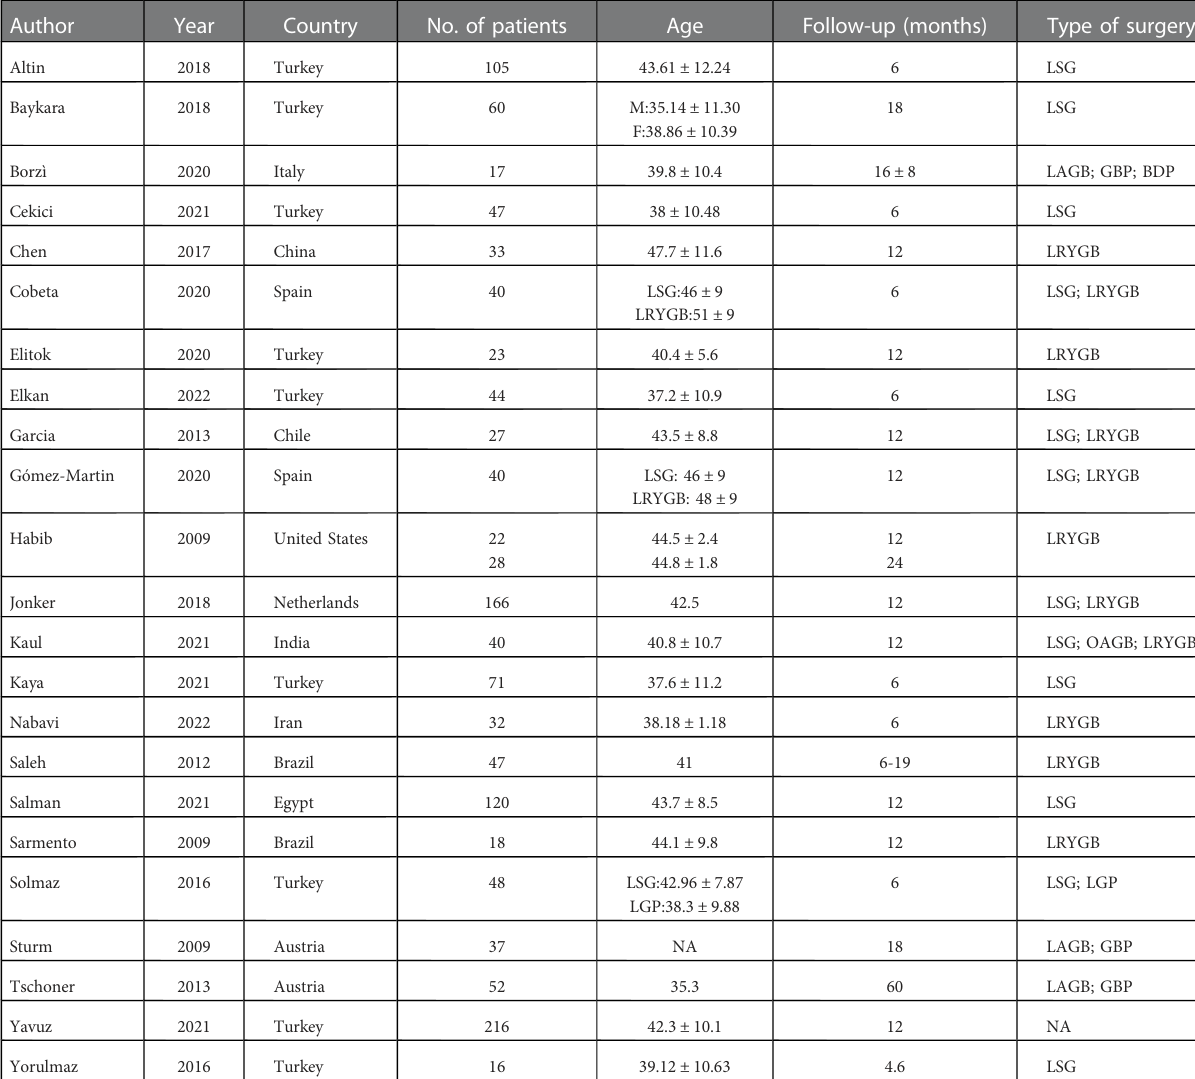
TABLE 1 Characteristics of all the studies included in the meta-analysis.